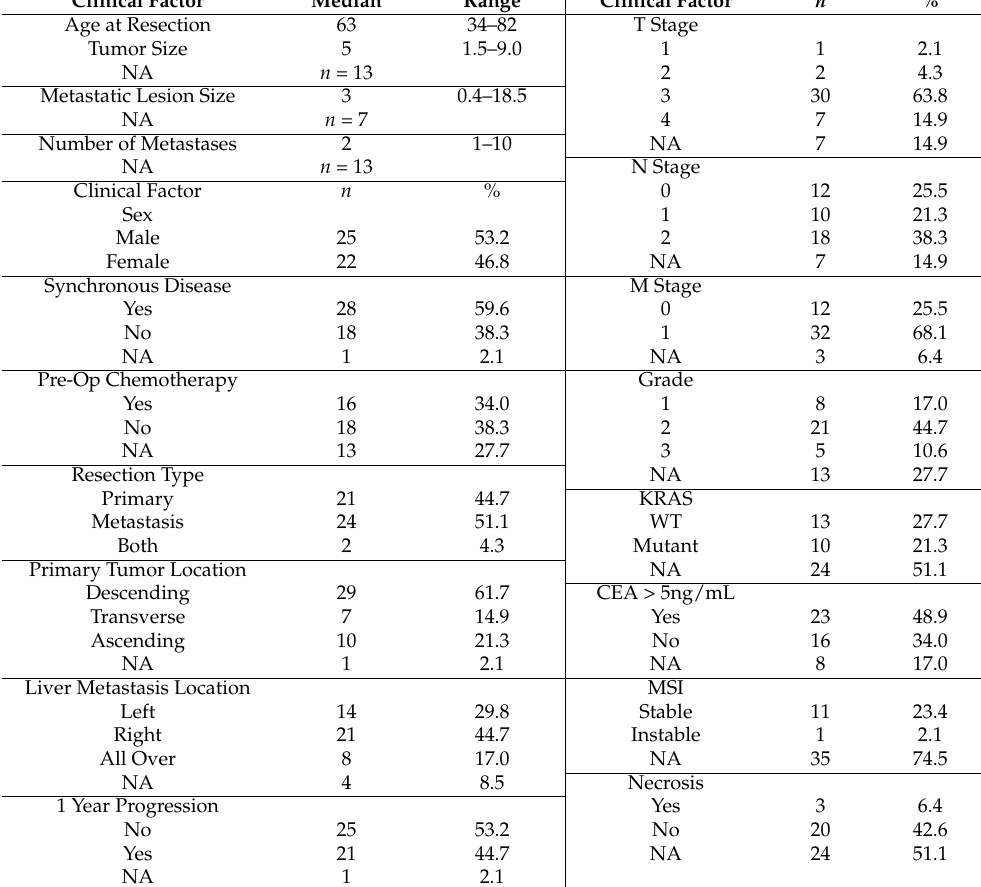
Table 1. Patient demographics and clinical disease characteristics. NA: not